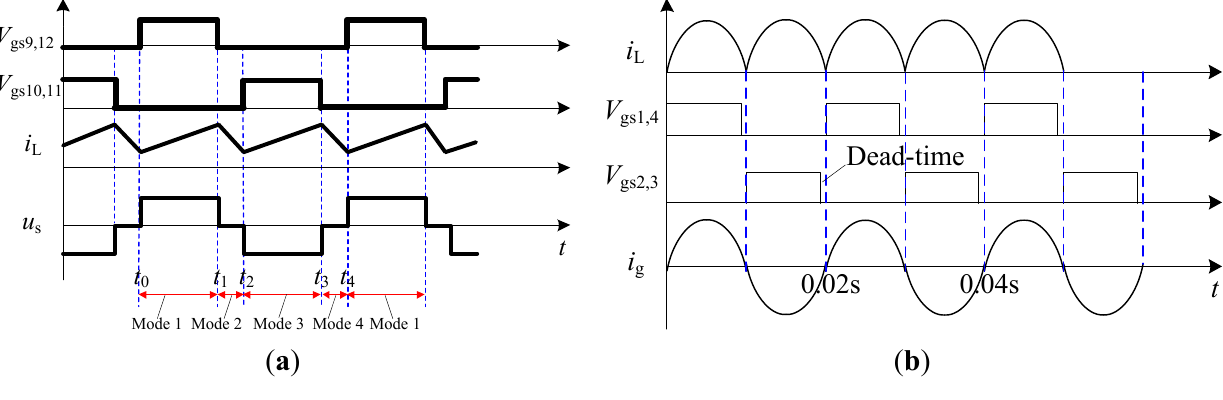
Figure 12. Operational principle of BSS-FBC in discharging mode: ( a ) High-frequency waveforms of this novel topology; ( b ) Line-frequency waveforms of this novel